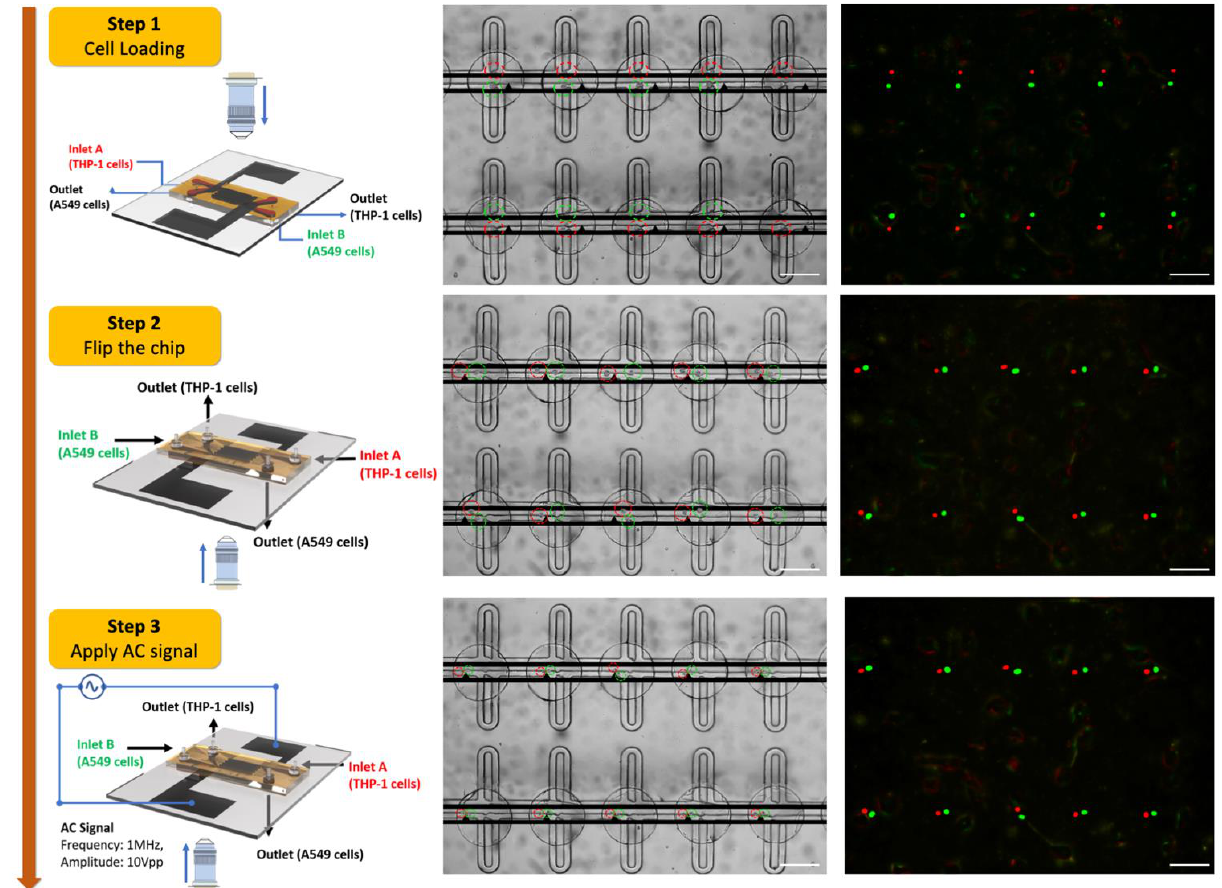
Figure 3. Illustration of MFC device operation for cell loading and pairing. Step 1: THP-1 cells and A549 are loaded from the respective inlets sequentially, followed by a washing step to flush out excess cells. Step 2: The chip is flipped, and the cells are transferred to the fusion wells. Step 3: The cell – cell contact is achieved by applying the AC signal (Frequency: 1MHz, Amplitude: 10V pp ). The illustration of an objective lens and an arrow indicates the direction from which the image was captured. Scale bar: 200 µm.